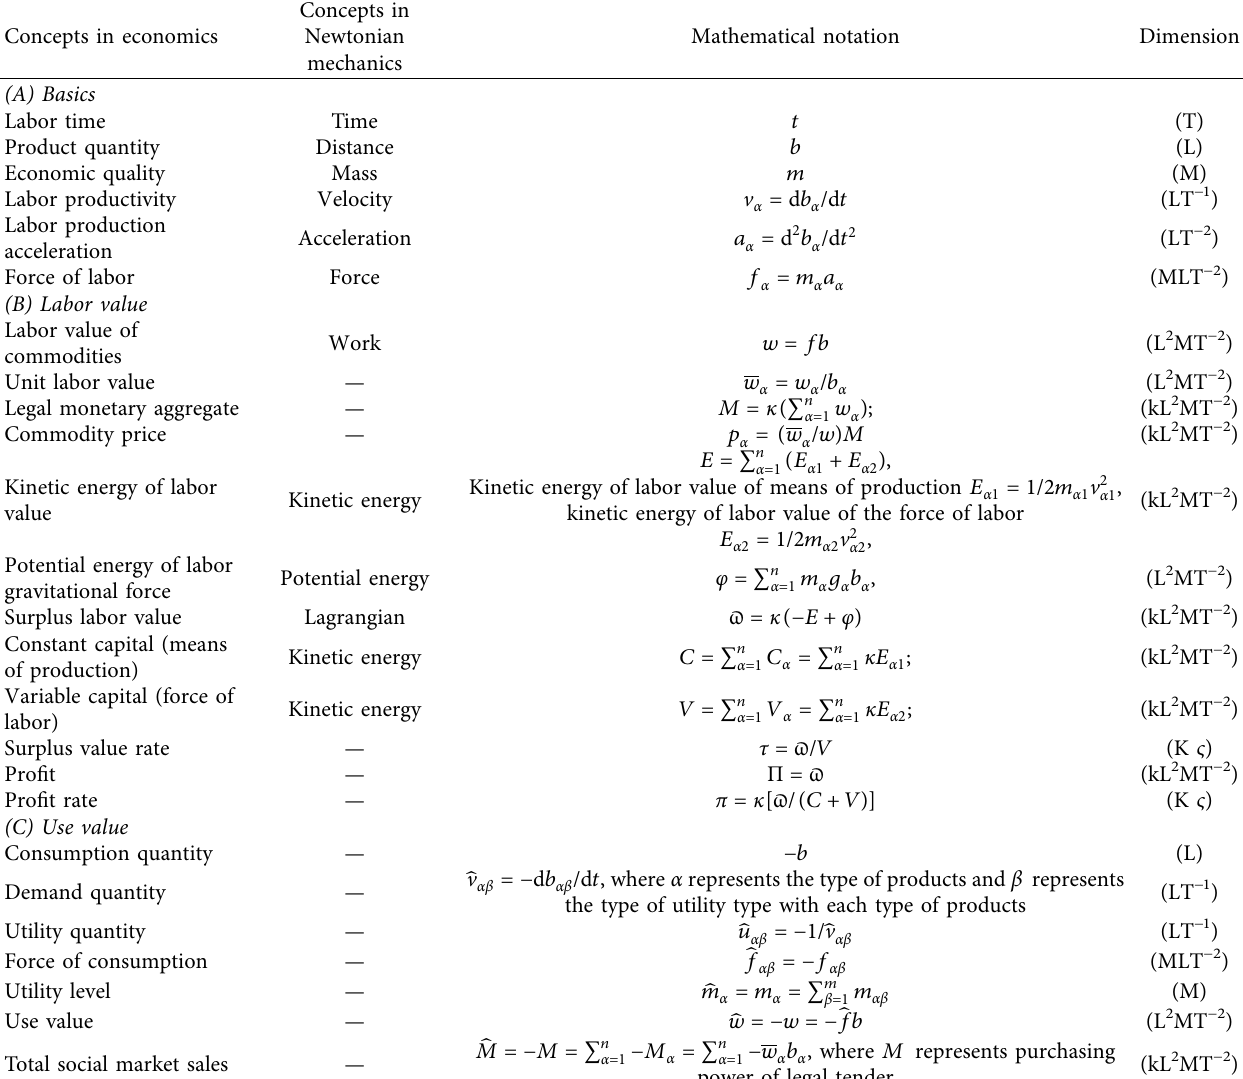
Table 1: The definitions of labor value and use value in new theory of value and their counterpart in Newtonian mechanics. Concepts in